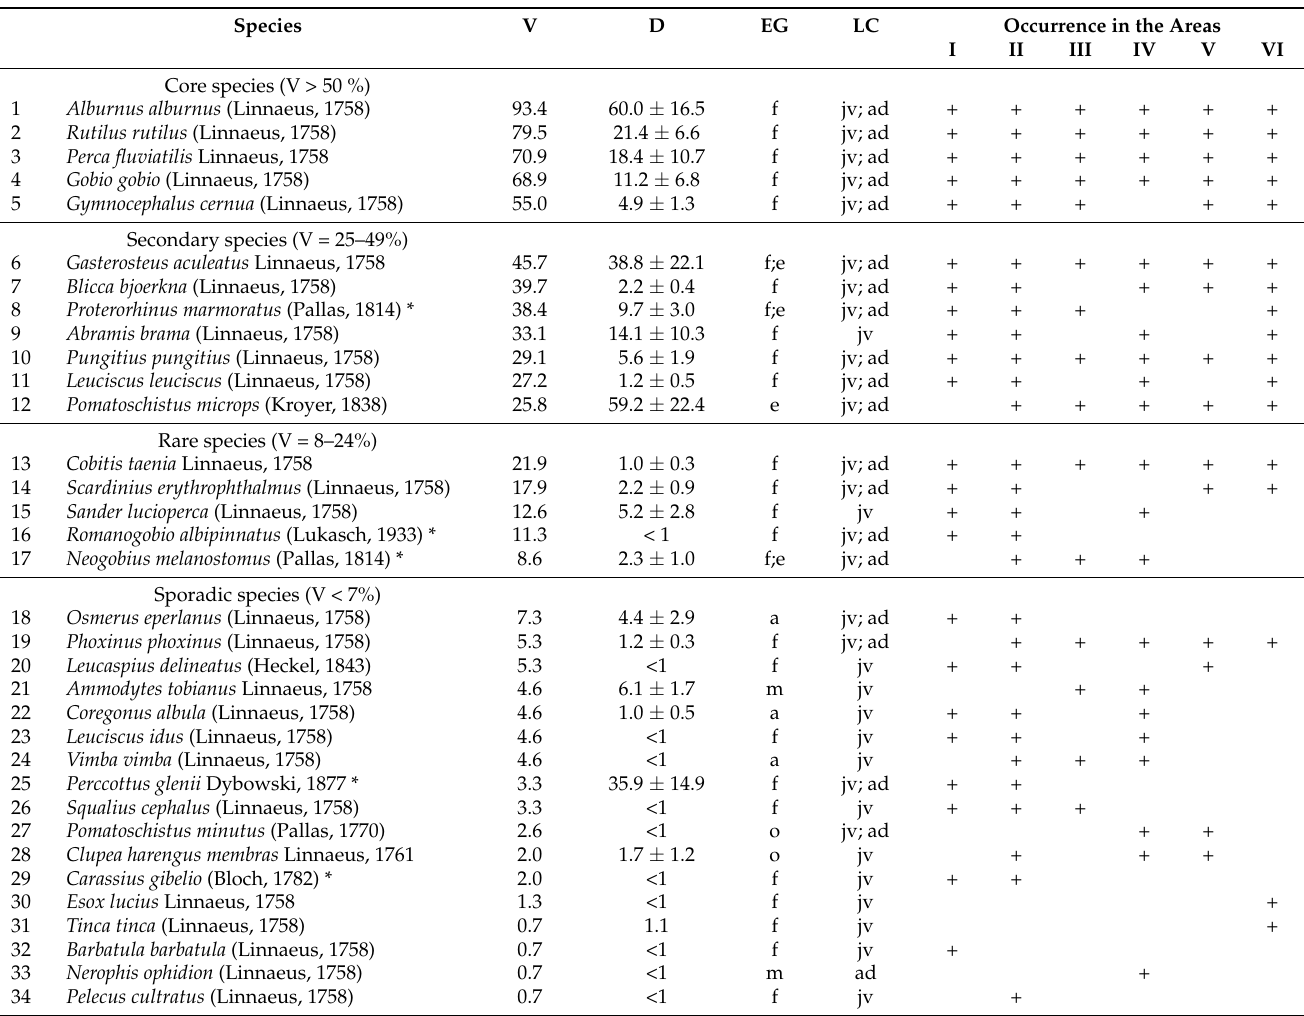
Table 2. Frequency of occurrence (V; %), mean density (D; ind./100 m 2 ) of different fish species in the eastern Gulf of Finland in